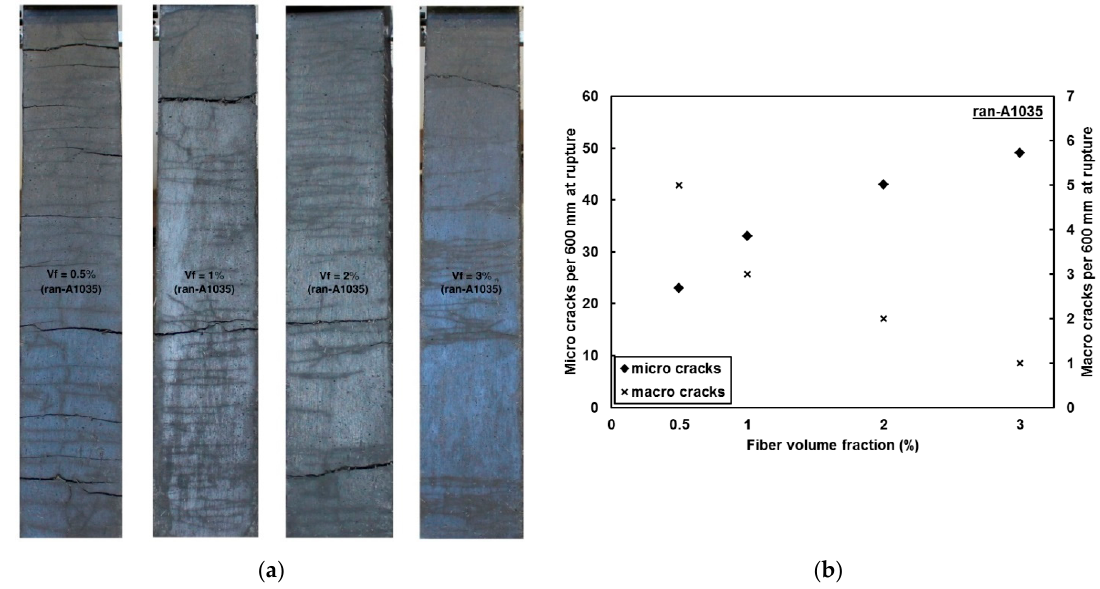
Figure 20. Failure of specimens w.r.t. fiber volume fraction: ( a ) Failure patterns; ( b ) Number of cracks.